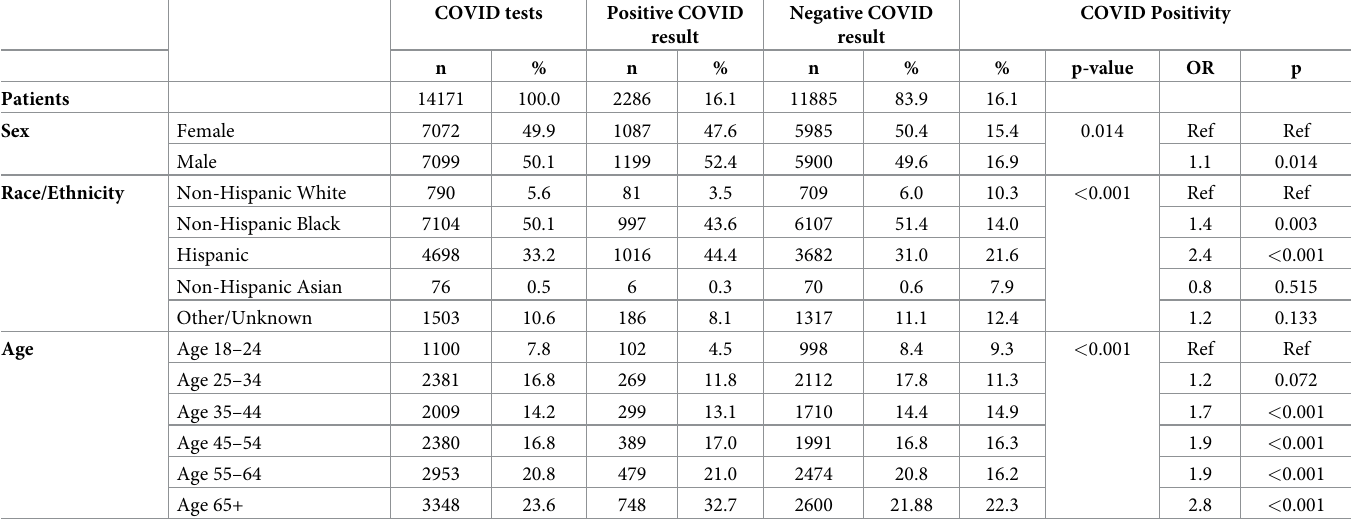
Table 1. Patient COVID-19 tests and results by sex, race, and age.